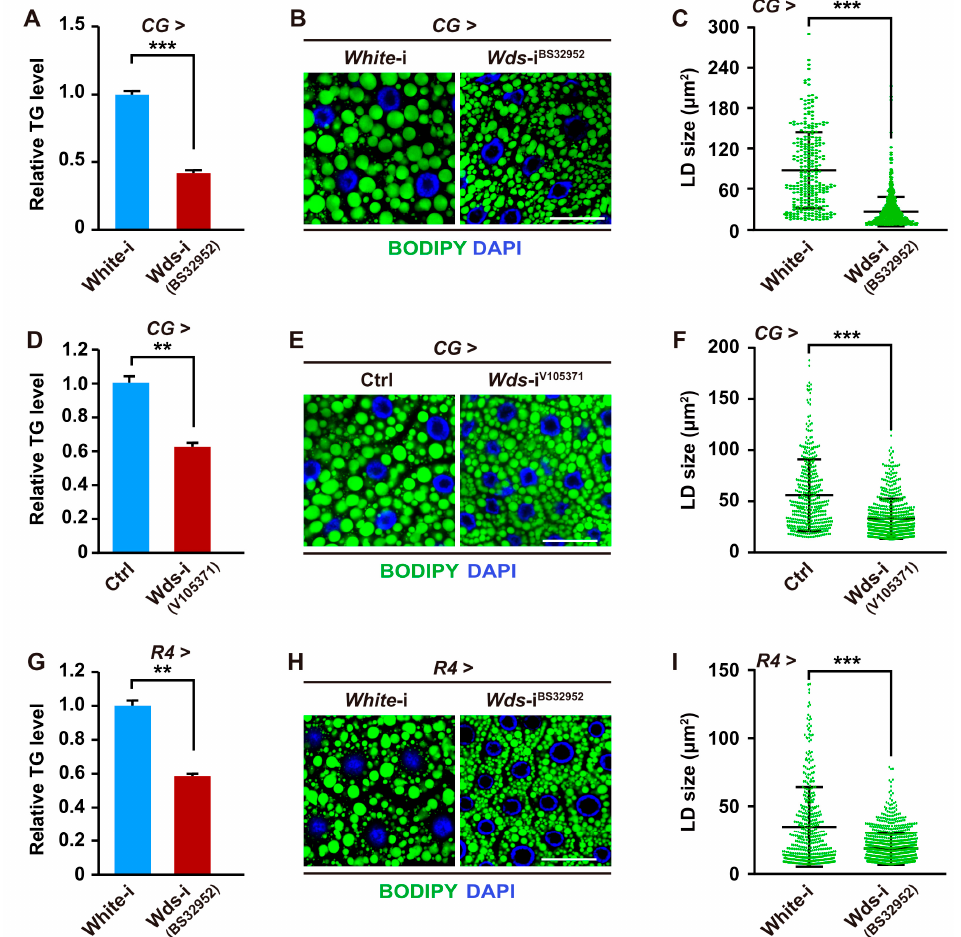
Figure 1. Wds knockdown in the Drosophila fat body impaired lipid content. ( A – C ) TRiP RNAi line (BS32952)-mediated Wds knockdown of Drosophila larvae using CG-Gal4 decreased the TG levels (n = 3, 10 larvae per group) of third instar larvae ( A ). This genetic manipulation for Wds was used hereafter unless otherwise indicated. Fat body-specific Wds knockdown decreased the LD size in the fat body of third instar larvae ( B , C ). Quantification of LDs size ( C ). Each point represents a single LD. BODIPY, green; DAPI, blue. Scale bar, 50 µ m. ( D – F ) VDRC RNAi line (V105371)-mediated Wds knockdown in the fat body using CG-Gal4 decreased TG levels (n = 3, 10 larvae per group) of third instar larvae ( D ) and reduced LD size ( E , F ) in the fat body of Drosophila third instar larvae. V60100 line was used as control. ( G – I ) TRiP RNAi line (BS32952)-mediated Wds knockdown in the fat body using R4-Gal4 decreased TG levels (n = 3, 10 larvae per group) of third instar larvae ( G ) of Drosophila larvae and reduced LD size ( H , I ) in the fat body. Each point represents a single LD ( H ). BODIPY, green; DAPI, blue. Scale bar, 50 µ m. Data are presented as the mean ± SE (error bars). For the significance: ** p < 0.01 and *** p < 0.001 versus the control.